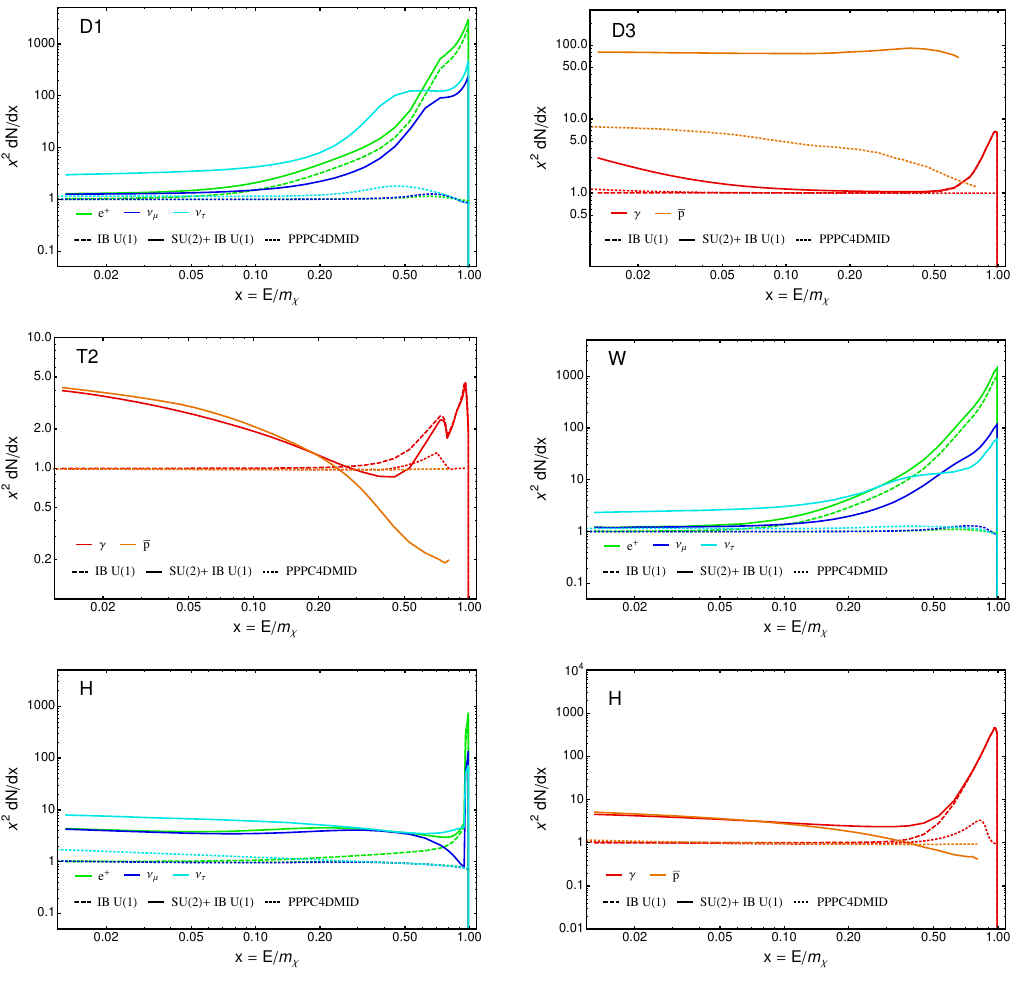
Figure 15 . Ratio of three-body to two-body yields, for some of the benchmark models from table 6. Solid lines show the full ratios, while dashed lines indicate the contribution from photon IB alone. Dotted lines show the result from the method implemented in the ‘Poor Particle Physicist Cookbook for Dark Matter Indirect Detection’ (PPPC4DMID) [17]; note that the relatively small resulting corrections are not restricted to these benchmark models but generic for neutralino